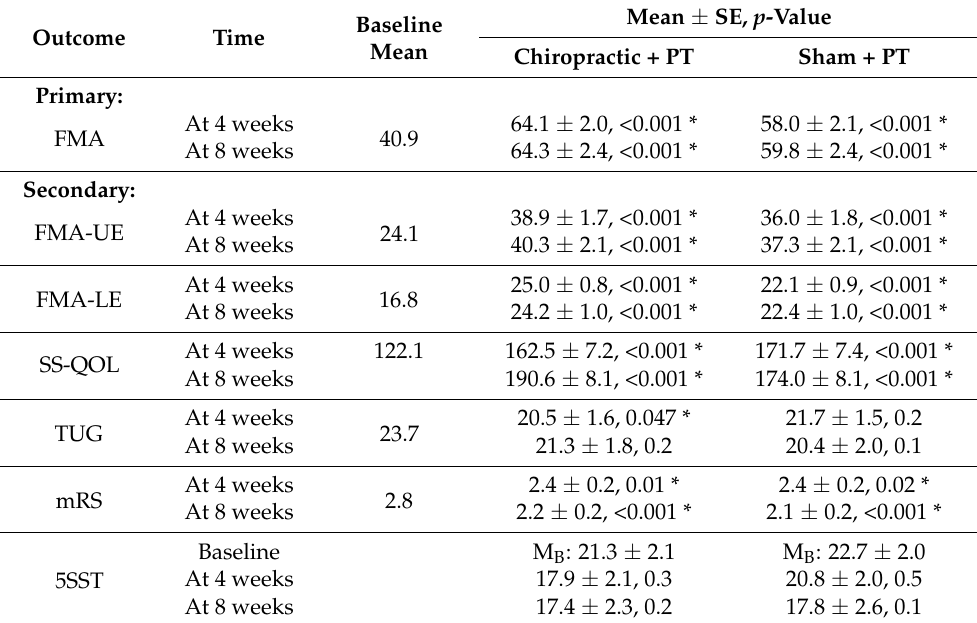
Table 4. Estimated within-group marginal mean differences for primary and secondary outcome